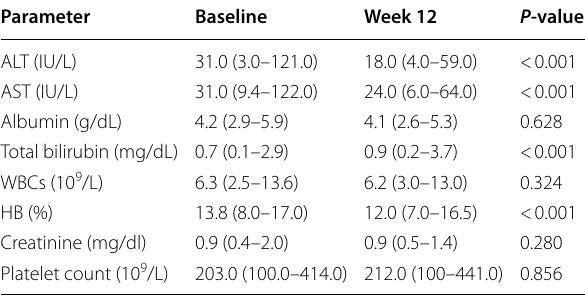
Table 4 Comparing baseline and end of treatment data in Gp2 ( N 81) =